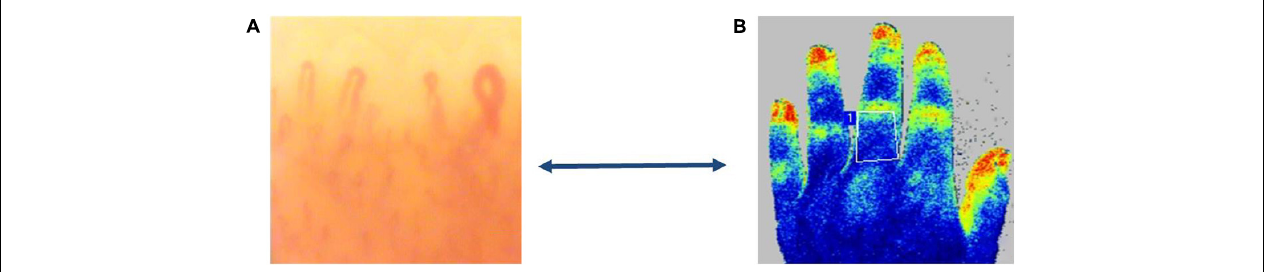
FIGURE 2 | Microvascular damage in systemic sclerosis. Evaluation of peripheral blood perfusion (PBP) by Laser Speckled Contrast Analysis (LASCA) in a patients with an “Early” capillaroscopy pattern (A) . Regions of interest (white line) created for evaluation of blood perfusion (BP) by LASCA (blue color, low BP, yellow color, intermediate BP, red color, higher BP) in a SSc patient (B) (Courtesy by